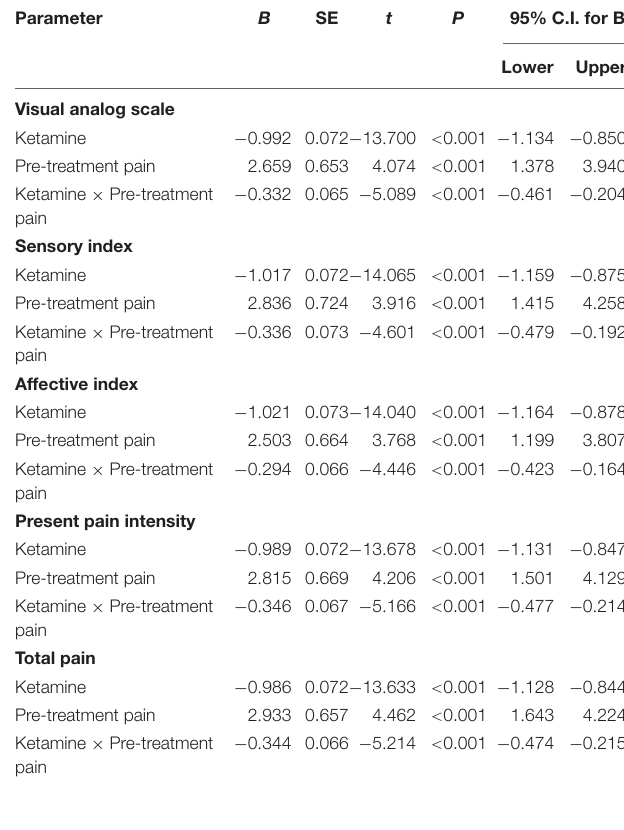
TABLE 2 | Comparisons of baseline depressive severity among severe, mild, and non-pain group. Variable